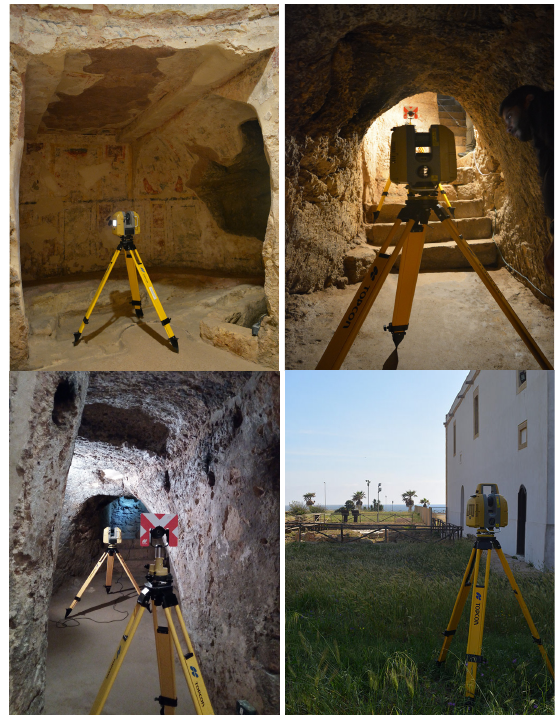
Figure 6. Terrestrial laser scanner